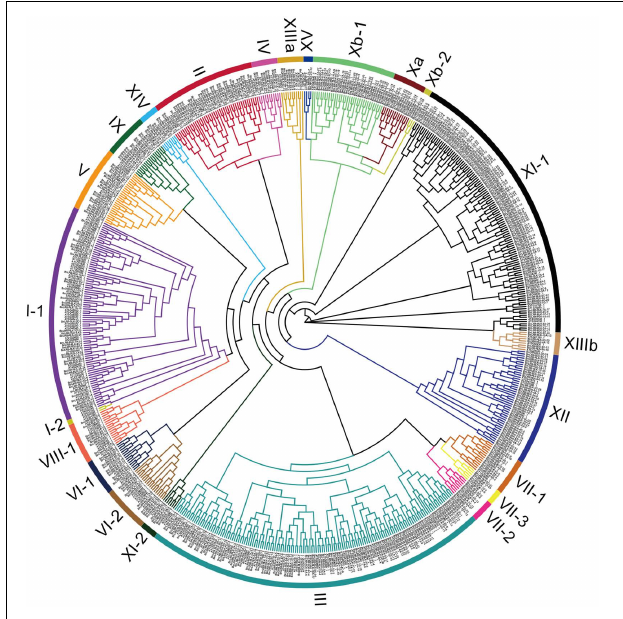
FIGURE 1 | Phylogenetic tree analysis of BnLRR-RLK gene family in B. napus . Fasttree software was used as the maximum likelihood method for constructing phylogenetic trees with the protein sequences of B. napus and A. thaliana . The color clade illustrates the different